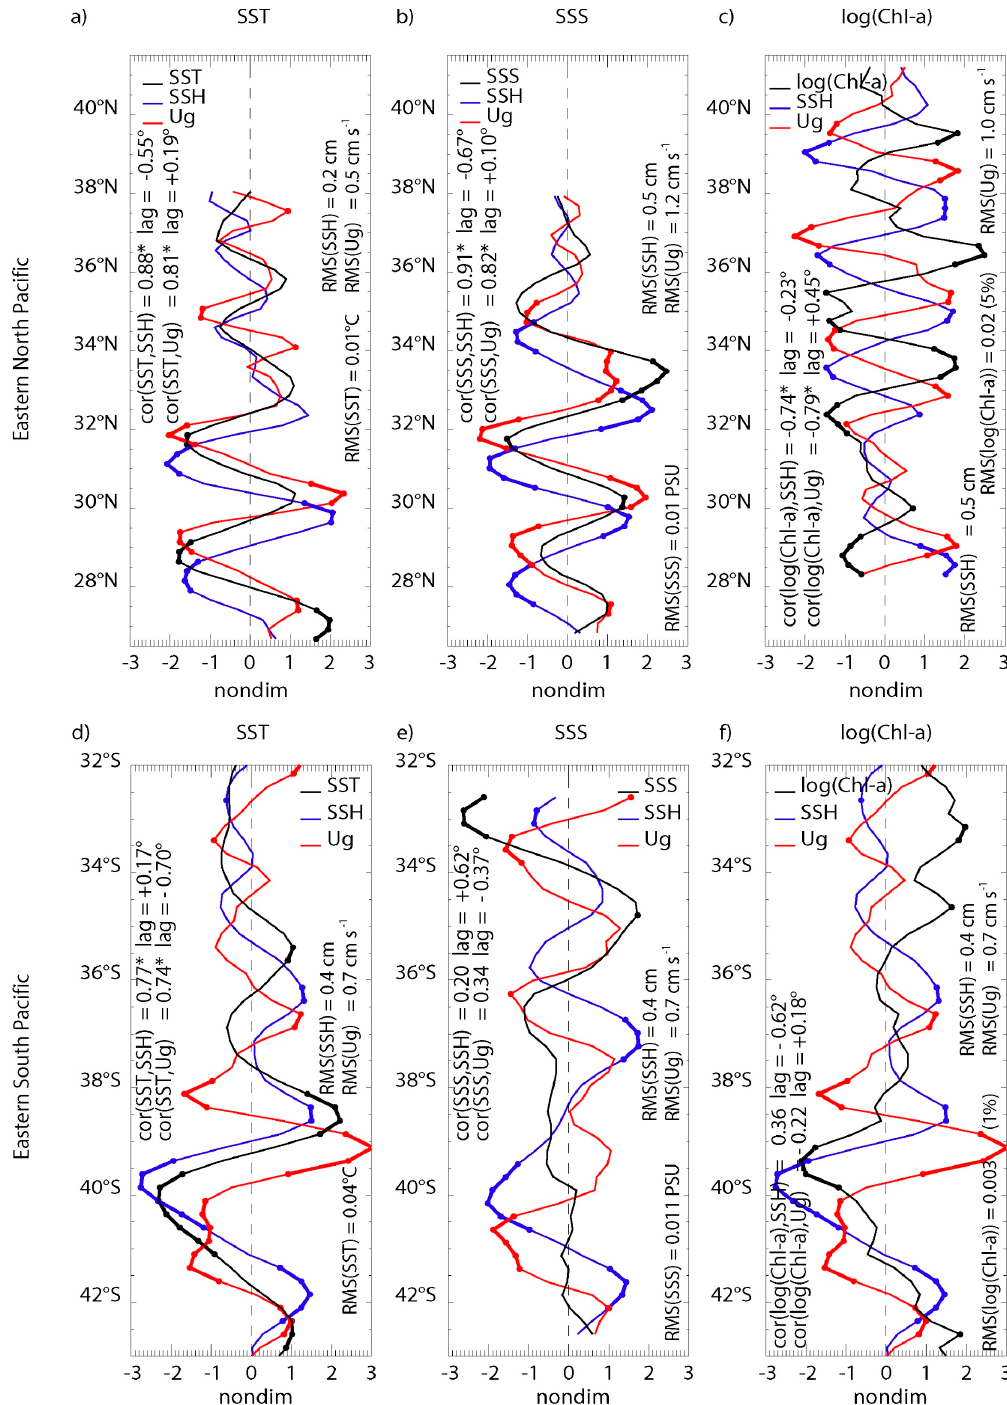
Figure 6. Cross-striation profiles of mean spatially high-pass filtered fields in the ( a – c ) ENP and ( d – f ) ESP, averaged quasi-zonally within the tilted solid boxes on Figures 2 and 3, and normalized by their standard deviation: black lines are for ( a , d ) AMSR-2 SST, ( b , e ) SMAP SSS, and ( c , f ) GlobColour log(Chl-a). The blue and red lines on all panels are for SSALTO/DUACS SSH and U g , respectively. The dots joined by the thick lines indicate where each profile is statistically significant at the 5% level (see Appendix C). The maximum positive or negative lag-correlations of each tracer profile with both SSH and U g are indicated, together with their associated lag (positive lag is when the tracer field is shifted southward). The stars (*) indicate when the correlation is significant at the 5% level (see Tables S1 and S2). The standard deviation of each profile before normalization is also indicated, ( c , f ) together with that of the associated Chl-a profile expressed as a fraction of full Chl-a (%, see Figures 2e and 3e, Appendix C).